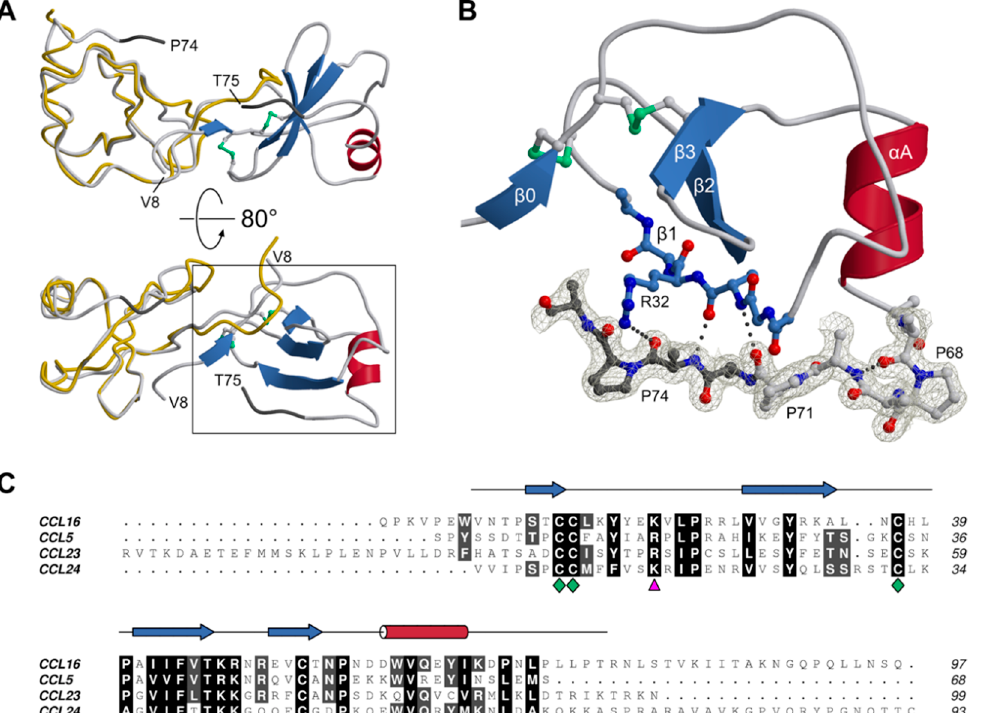
Figure 4. The crystal structure of human CCL16. ( A ) CCL16 forms a canonical CC-type dimer. One of the protomers (chain B, right) is shown in ribbon representation, the other (chain A, left) as a C α trace, on which the prototypical family member CCL5 (PDB-ID 1U4L [60], chain A, yellow) is superimposed for comparison. The C-terminal extension relative to CCL5 is coloured dark grey. ( B ) Close-up view of chain B, corresponding to the boxed area in ( A ), with a focus on the C-terminal extension and its interaction with the chemokine core domain. In the segments shown in all-atom mode, most side chains have been truncated for visual clarity. Electron density (2 mF o - DF c synthesis, contoured at 1.2 σ ) is displayed for residues 67–75; hydrogen bonds stabilising the conformation of the terminus are indicated by dotted lines. ( C ) Sequence alignment of CCL16 with other human CC-type chemokines, including CCL23 and CCL24, which carry unique extensions at their N- and C-termini, respectively. The degree of sequence conservation is indicated by shading; green diamonds mark the invariant cysteine residues, and purple triangles identify the BBxB motif in the β 2- β 3 loop and an additional basic residue in the N-loop, both of which are implicated in GAG binding. The secondary structure of CCL16 (chain B of our crystal structure) is depicted above the